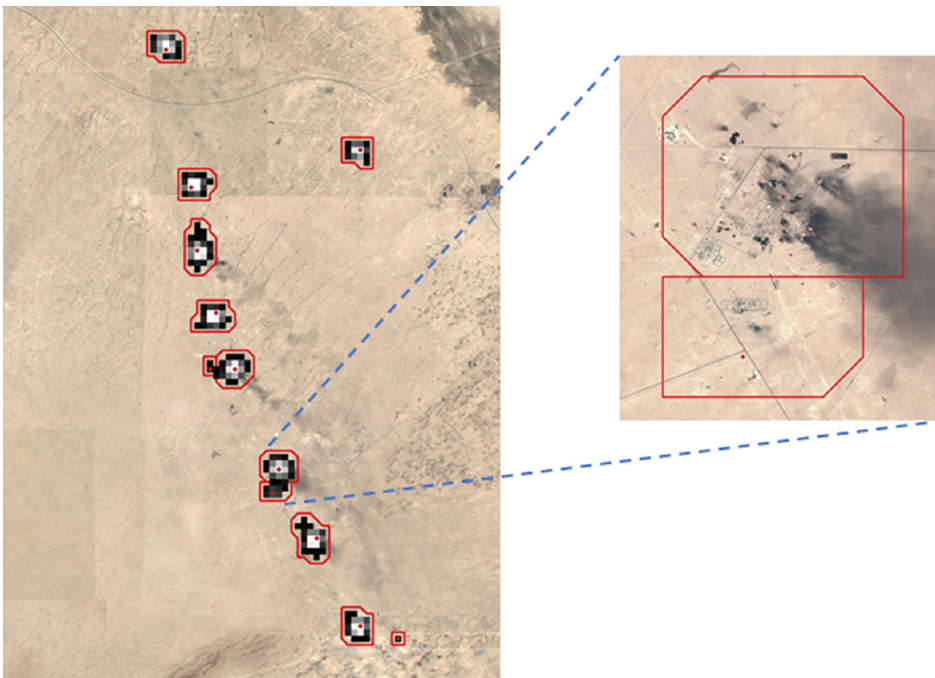
Figure 1. Probability map of detections and watershed contours for a chain of large flares in Basra, Iraq, overlaid with daytime image from Google Earth.